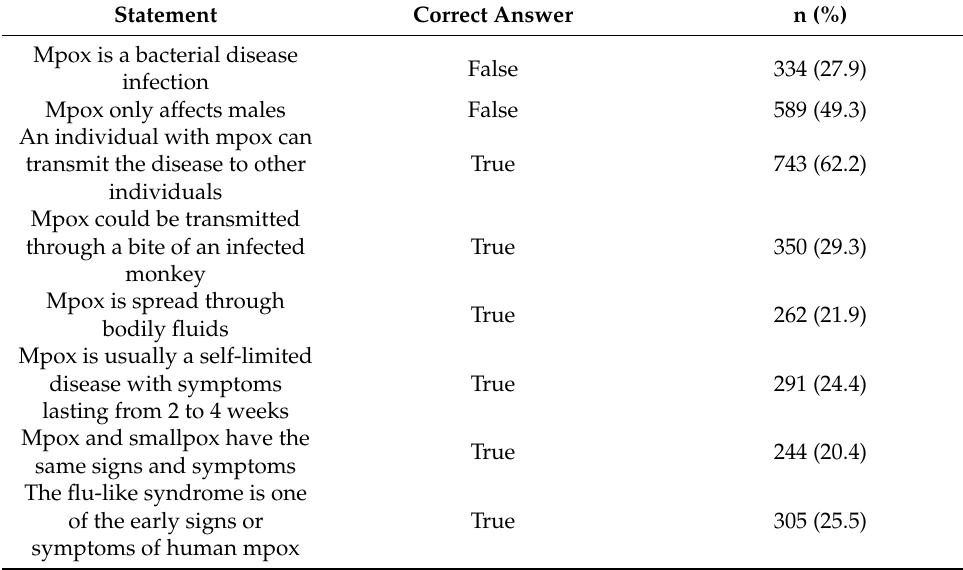
Table 3. Participants’ knowledge about human mpox (n =